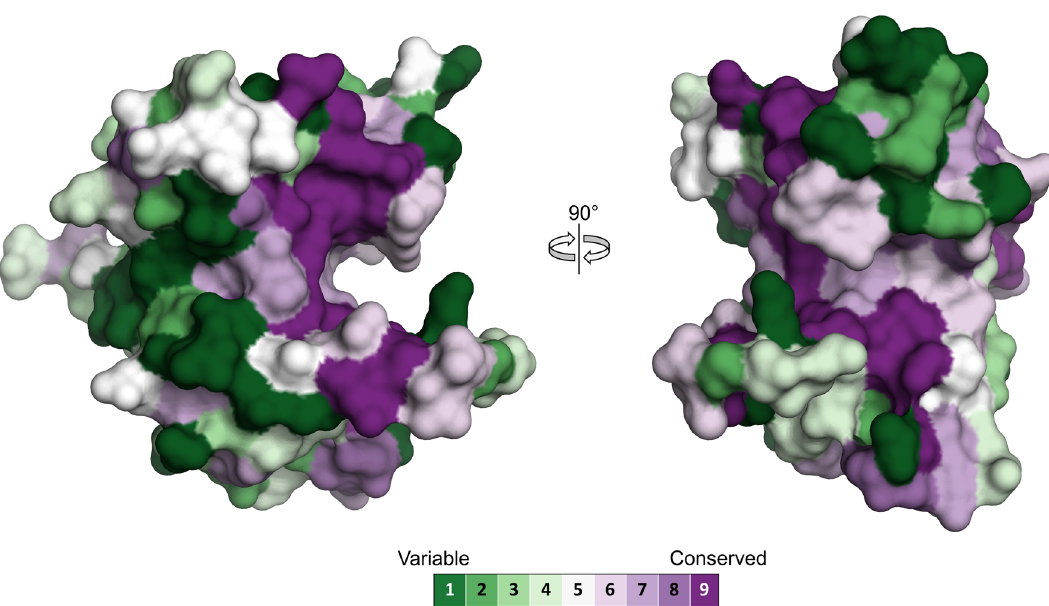
Figure 3. Amino acid conservation in the Enc34 endolysin. The analysis was performed on the ConSurf server 26 with the default parameters for homolog search and multiple sequence alignment. The residues are colored according to the ConSurf conservation score (see